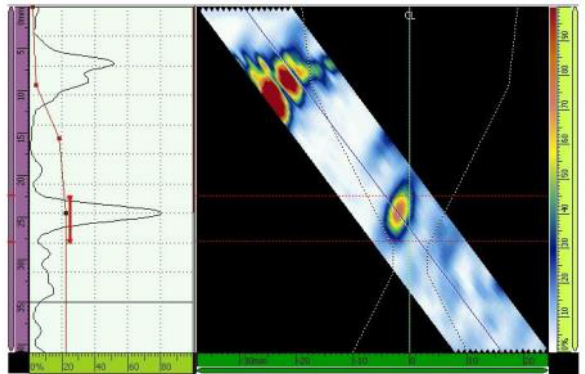
16 active elements. Primary gain = 40.1 dB.